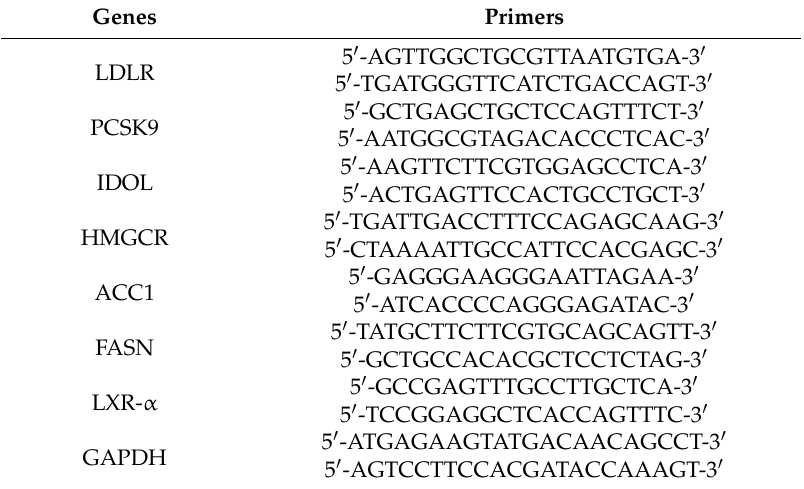
Table 2. Gene-specific primer pairs used in real-time